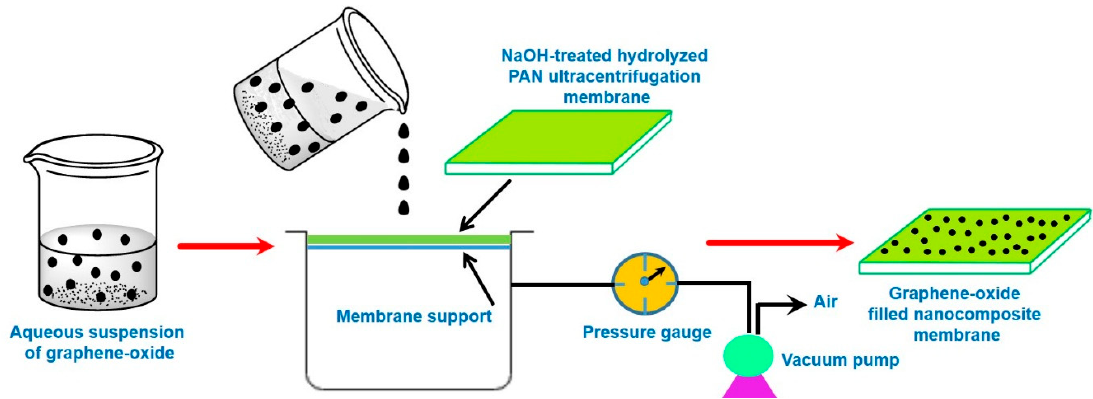
Figure 10. Vacuum filtration assisted assembly